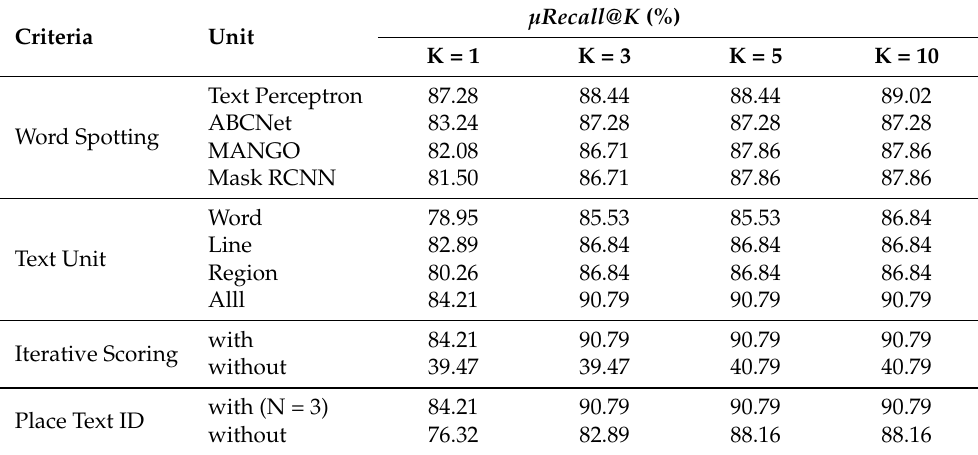
Table 3. Evaluation of submodules.